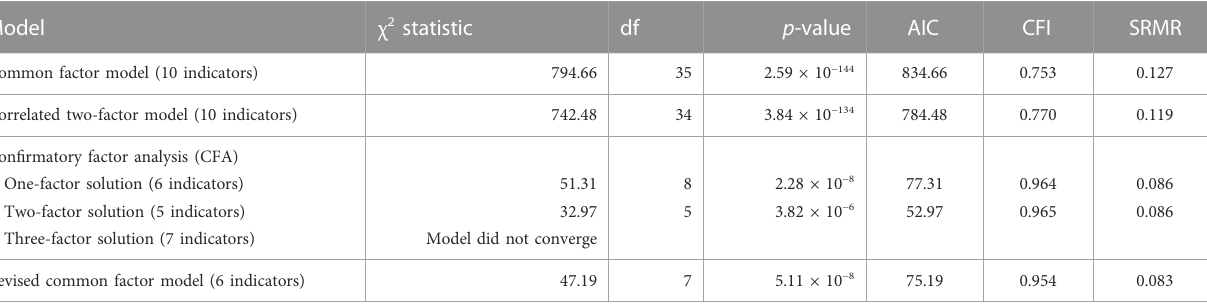
TABLE 3 Model fi t statistics for each of the SEM models performed.